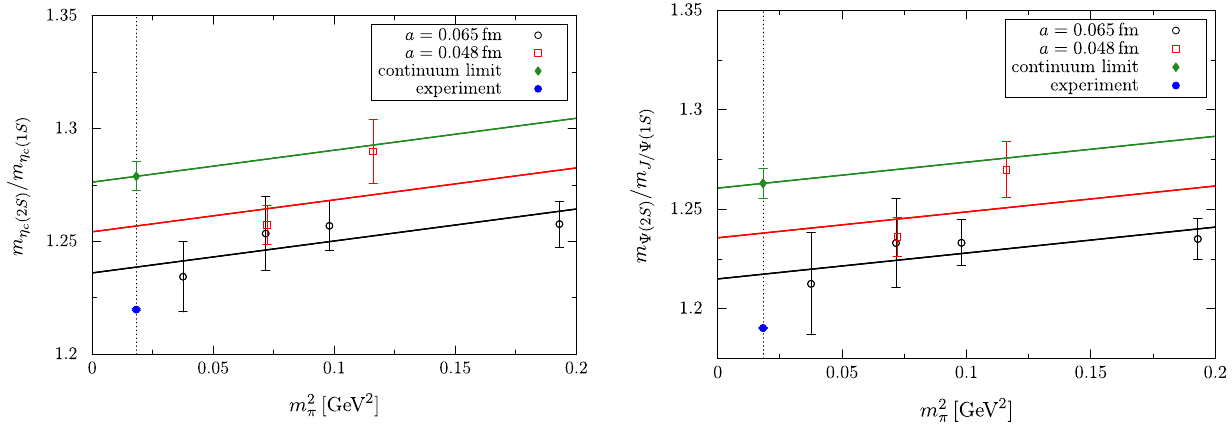
/ m η (left panel) and m ψ( 2 S ) / m J /ψ (right panel) by linear expressions in m 2 π and a 2 . Errors c c ( 2 S )